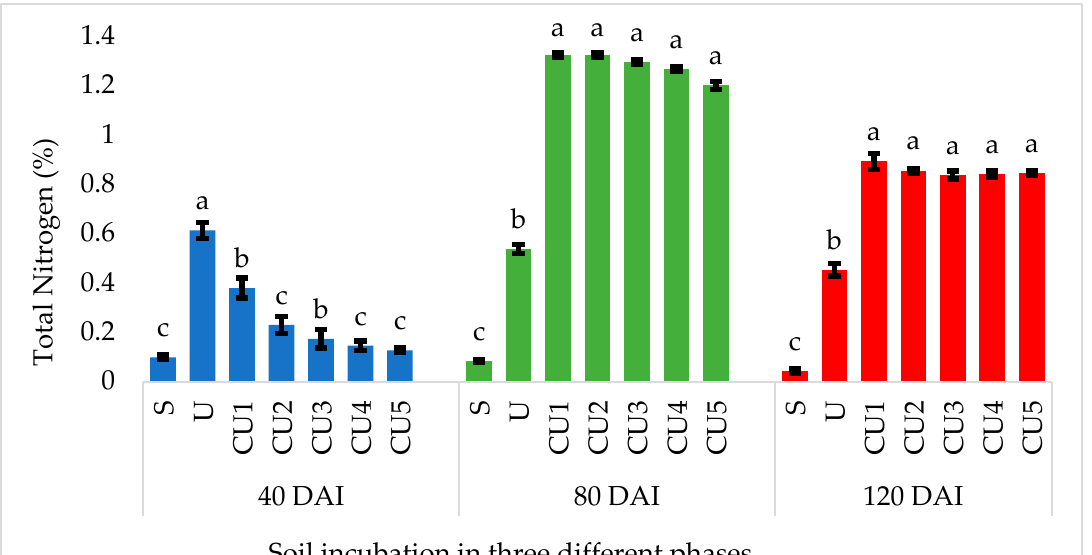
Figure 7. Nitrogen released from uncoated and RSS-coated urea in soil incubated for 40, 80, and 120 days. Note: S—soil only; U—uncoated urea; CU1, CU2, CU3, CU4, and CU5—urea coated with different concentrations of rejected sago starch [57]. Means with different letter(s) within the same incubation period indicate a significant difference between treatments, determined by Duncan’s new multiple range test (DNMRT) at p ≤ 0.05. Bars represent the mean values ± SE.